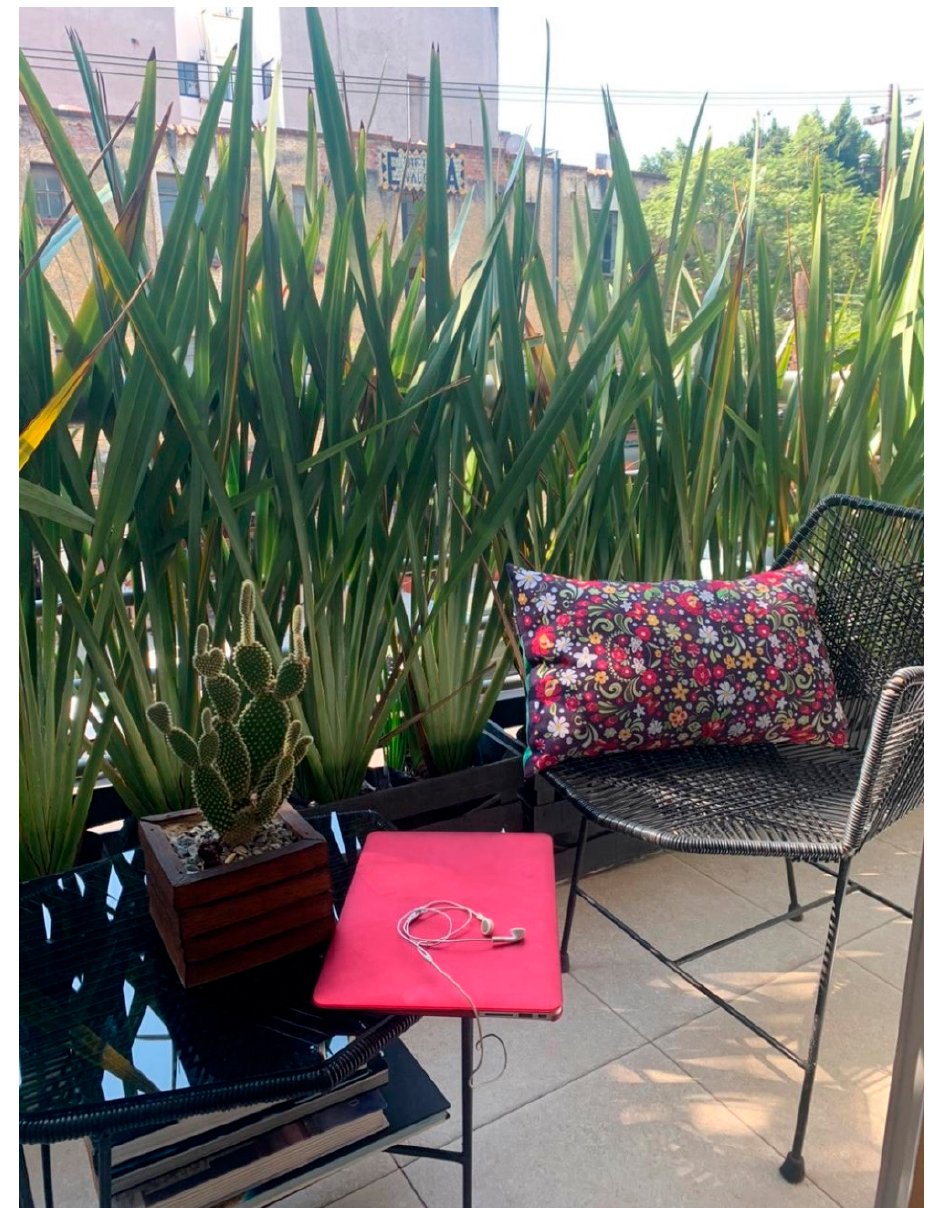
Figure 9. Outdoor patio inside Participant 4’s house.